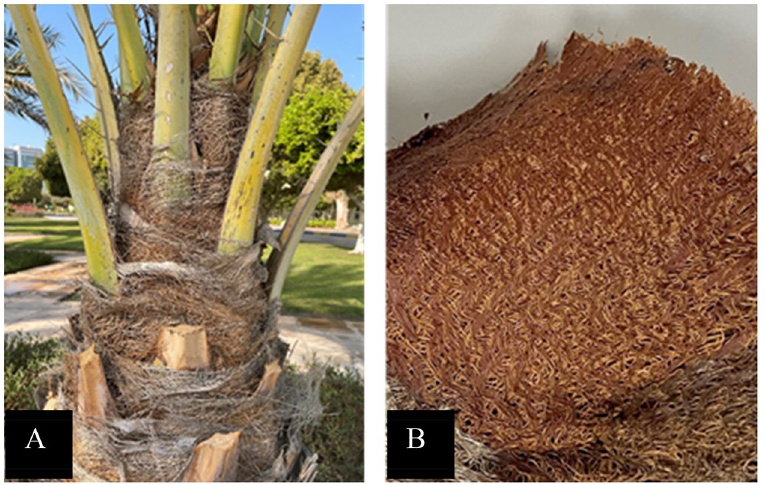
Figure 1. ( A ) DPF tree, ( B ) DPF meshes from date palm